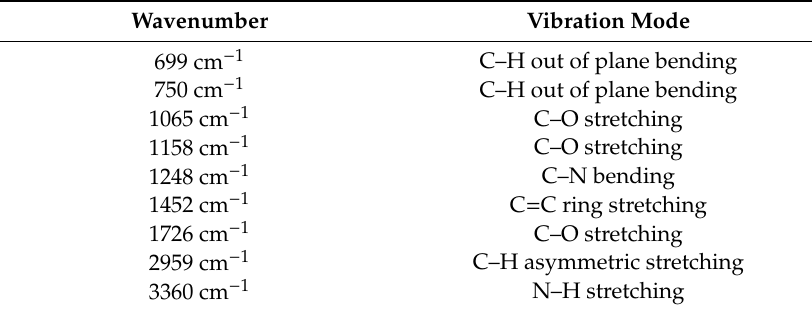
Figure 5. Comparison of FTIR spectra of PANI synthesized in two different discharge electrode structures such as the proposed DBD and previous DC structures, including liquid aniline monomer. Table 1. FTIR peaks of PANI synthesized in both DBD and DC structures.